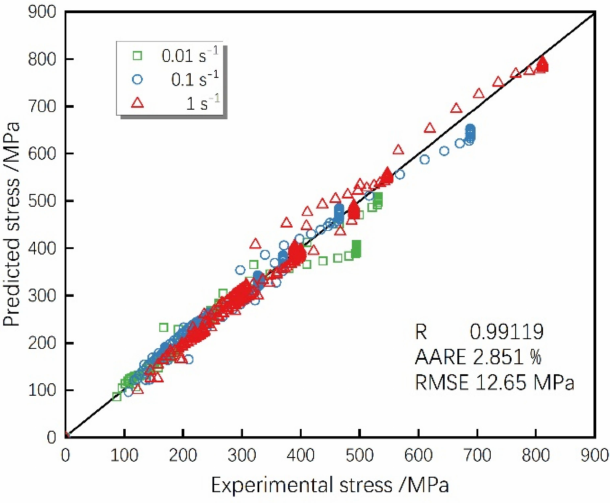
Figure 8. Linear correlation plot of Predicted stress-Experimental